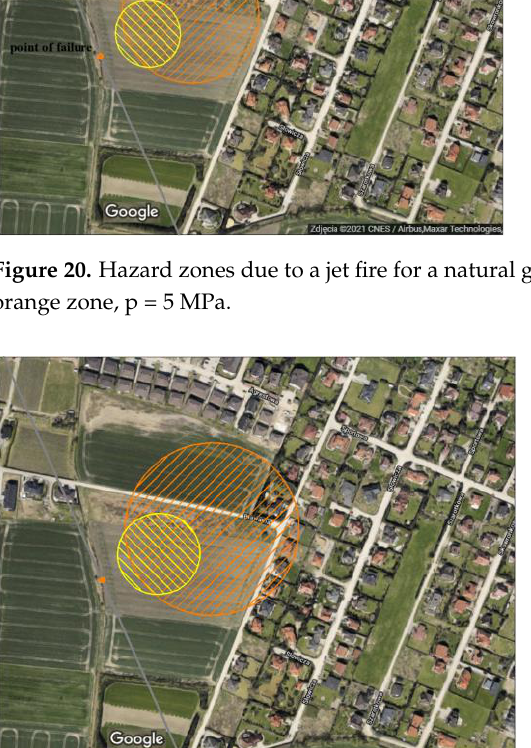
Figure 21. Hazard zones due to a jet fire for a natural gas pipeline (a = 0.5): yellow zone, p = 1 MPa; orange zone, p = 5 MPa.